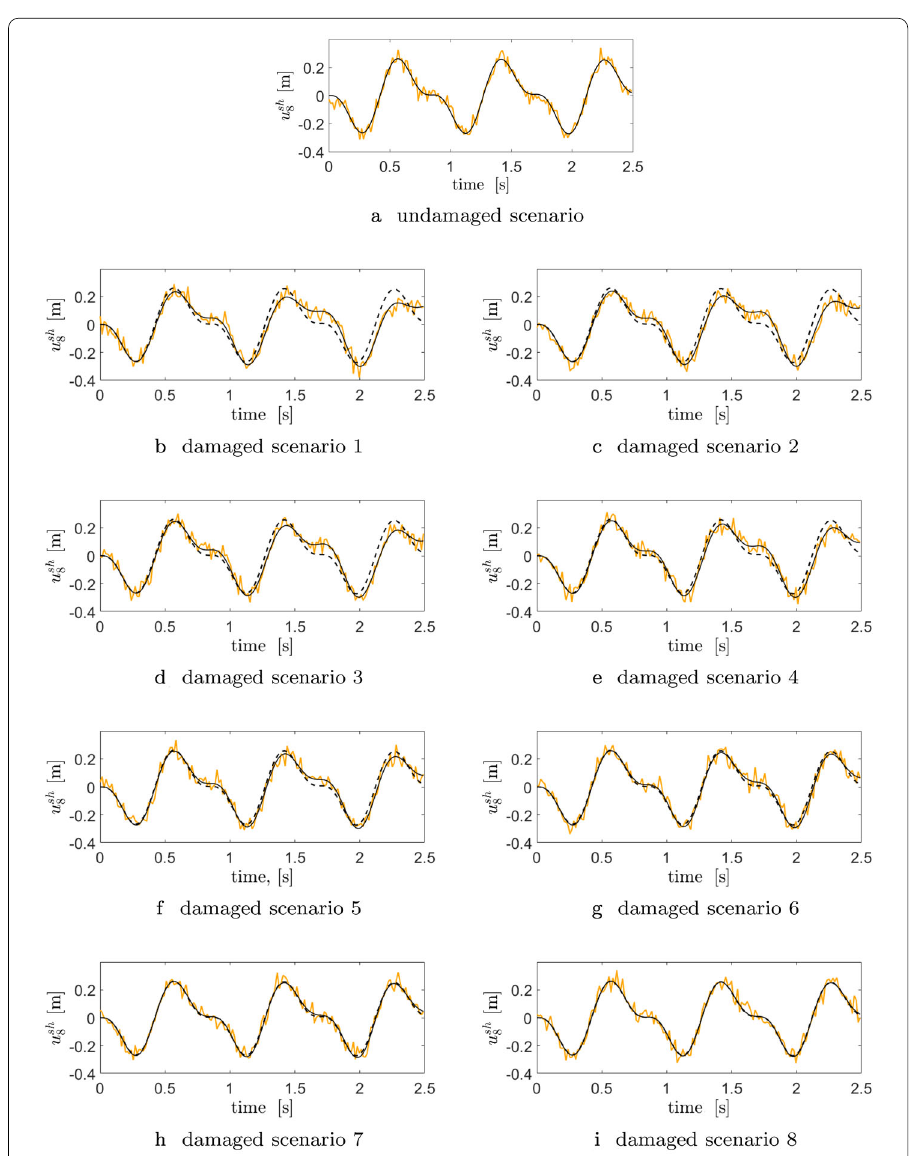
Fig. 9 Example of time evolutions of displacements in the x direction of the 8-th story for SNR = 10 dB, with = (14 . 5 , 2 . 36), γ sh = (0 . 025 , − 0 . 159), in the undamaged scenario ( a ) and all possible damage scenarios f sh 1 , 2 1 , 2 ( b – i ). Orange lines represent u , whereas black lines stand for r , according to Eq. (2). To show the effects of damage on the structural dynamics, the black dotted lines in b – i report the noise-free structural dynamics related to the undamage scenario